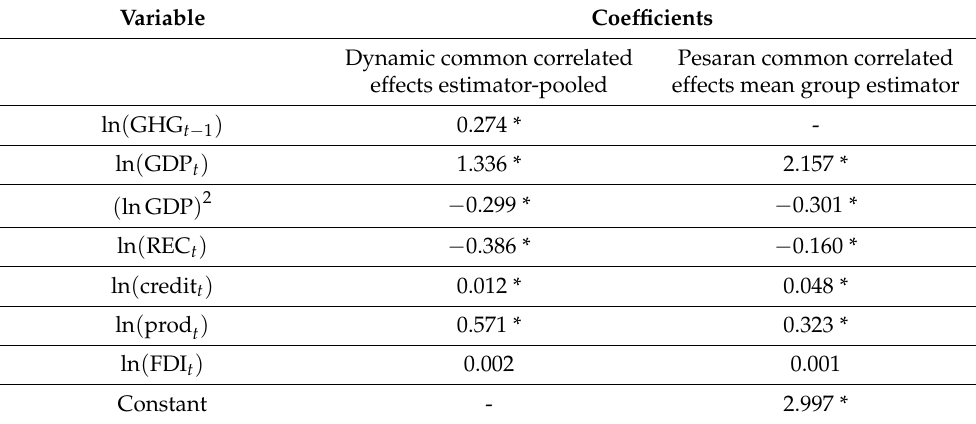
Table 11. Dynamic and Pesaran common correlated effects estimators to explain GHG emissions in RKC.